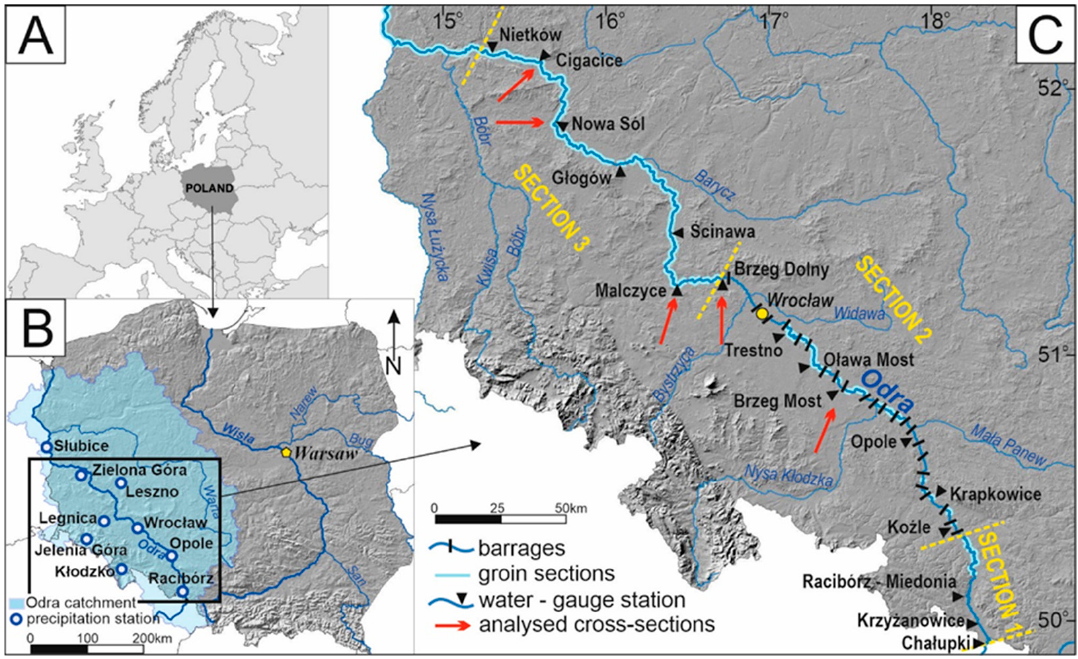
Figure 1. Location of Poland ( A ), the study sections of the upper and middle Odra River in south-western Poland, water-gauge sections and analyzed gauge cross sections in these river sections ( C ) and location of analyzed precipitation stations within the catchment of the upper and middle Odra River ( B ).